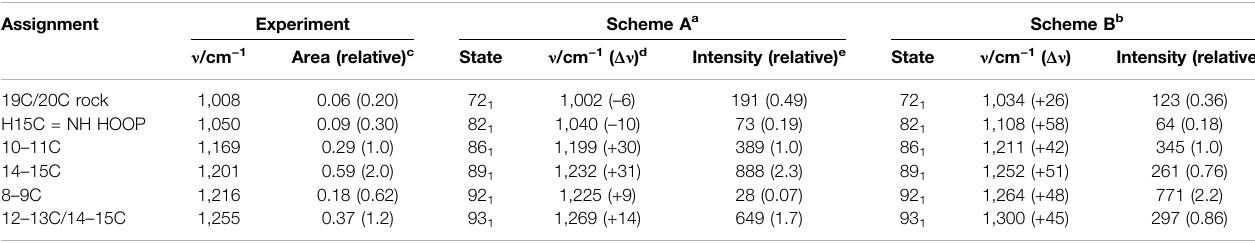
TABLE 1 | Assignment of bands to fundamental vibrational transitions of the retinal in the BR